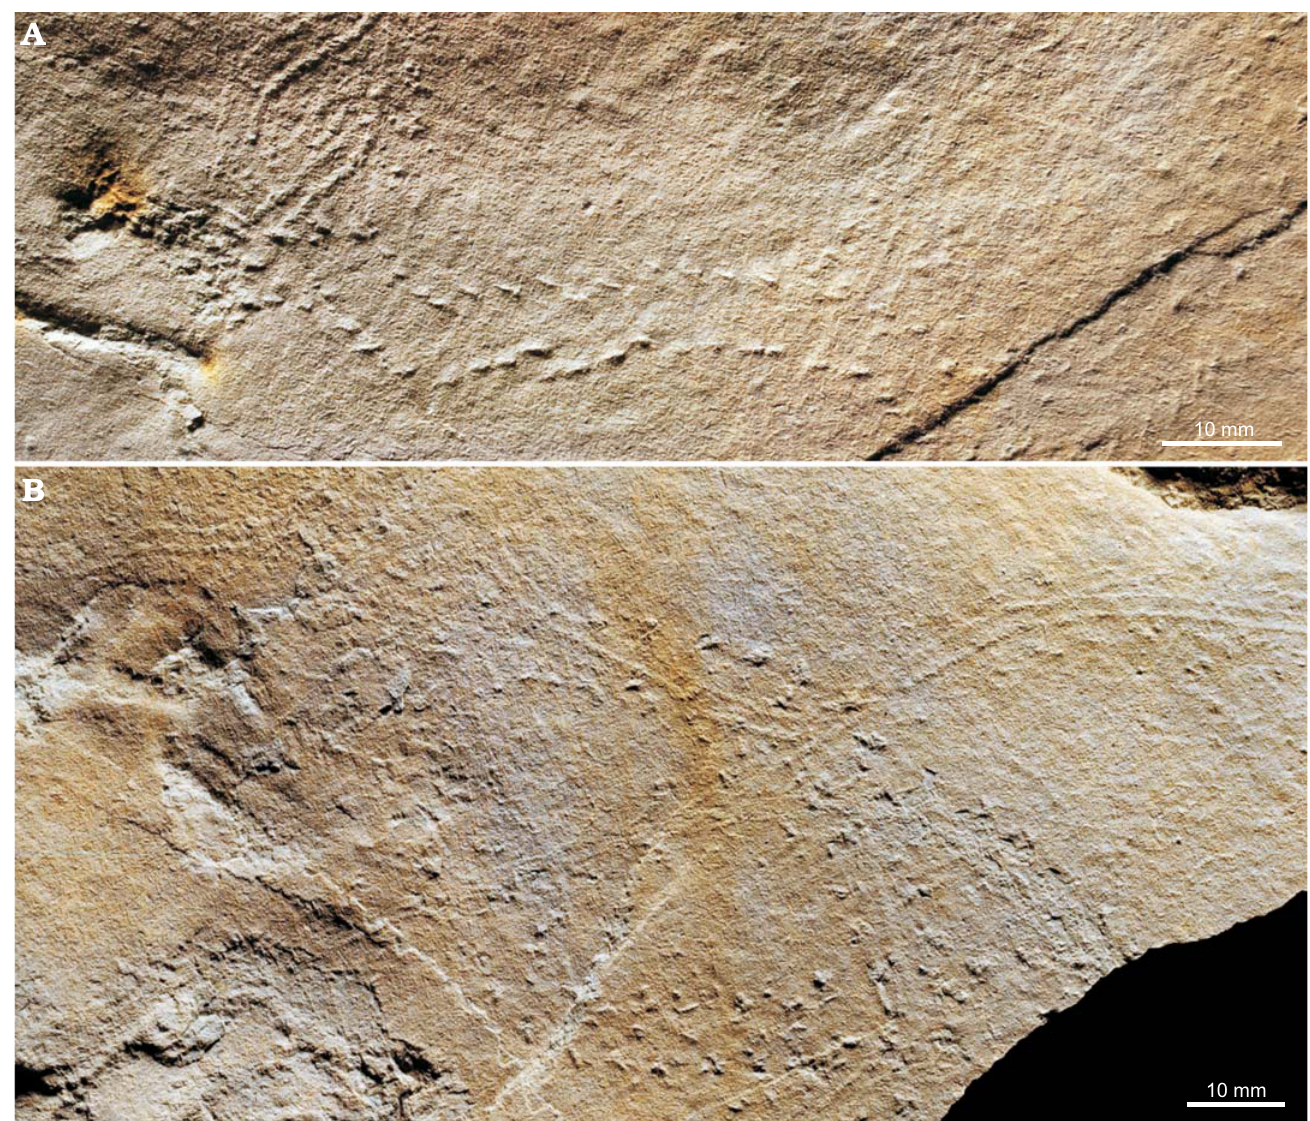
Fig. 11. Hypichnial trace fossil cf. Pterichnus isp., middle–late Eocene, Mount Wawel Formation, King George Island, Antarctica, slab ZPAL Tf.8/2007.14. A . Four footprints in the series are visible in the lower left side. B . Less regular form in the lower side and the bilobate median trail of Glaciichnium australis in the upper part, which resembles the trace fossil